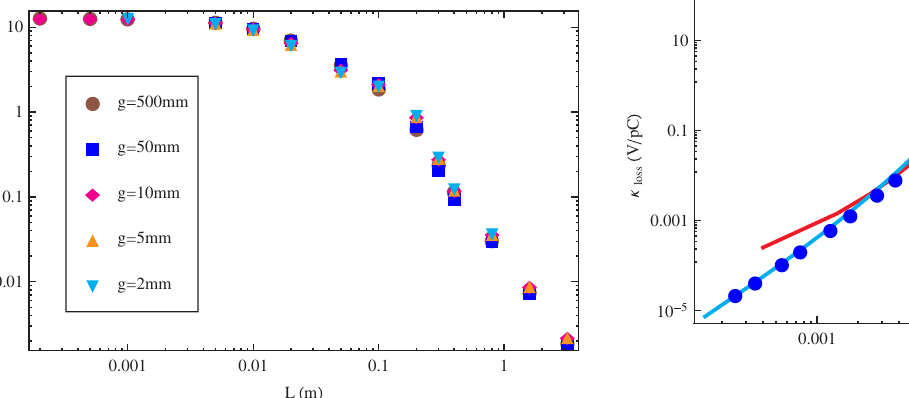
FIG. 14. (Color) ECHO results for the loss factor as a function of d (cid:2) b , for a tapered collimator with L ¼ 800 mm , g ¼ 500 mm , b ¼ 6 : 25 mm , and rms bunch length (cid:1) ¼ 0 : 5 mm , are shown by blue dots. The red curve is given by Eq. (3.1) and the aqua curve by Eq.